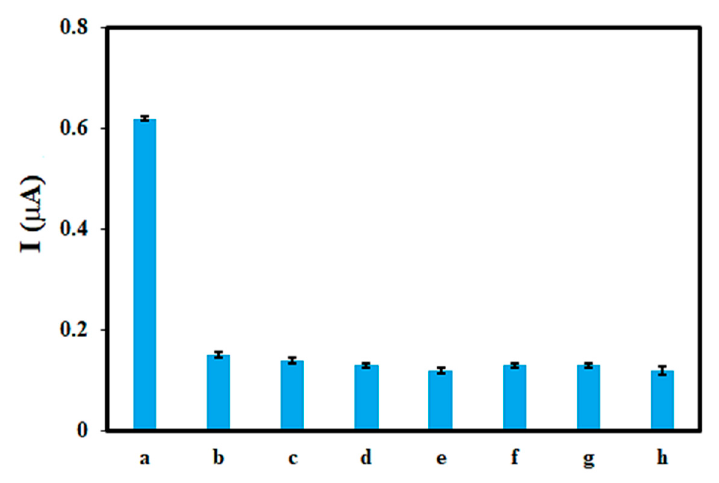
Figure 6. DPV responses in the presence of different amino acids (a) Trp and (b) tyrosine, (c) histidine, (d) arginine, (e) lysine, (f) valine, (g) methionine, and (h) blank. The concentration of Trp was 7 nM and other amino acids were 20 nM.